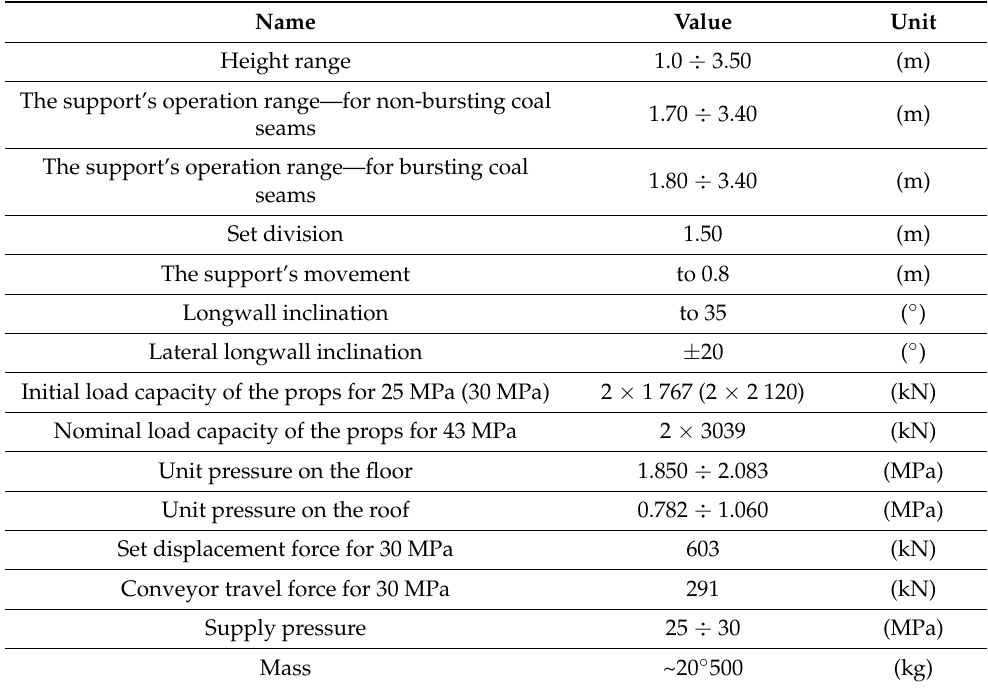
Table 1. Parameters of the tested section of powered